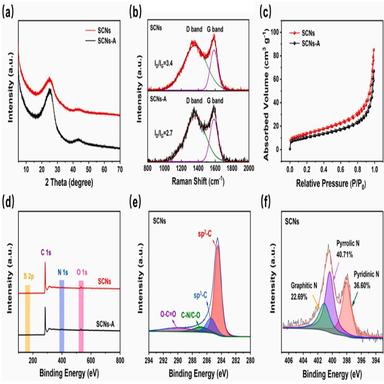
Structural and surface elemental characterization of SCNs and SCNs-A: a) XRD patterns, b) Raman spectra, c) nitrogen adsorption-desorption isothermal curves, and d) XPS survey spectra. e) High-resolution C 1s, and f) N 1s XPS spectrum of SCNs. (A colour version of this figure can be viewed online.)